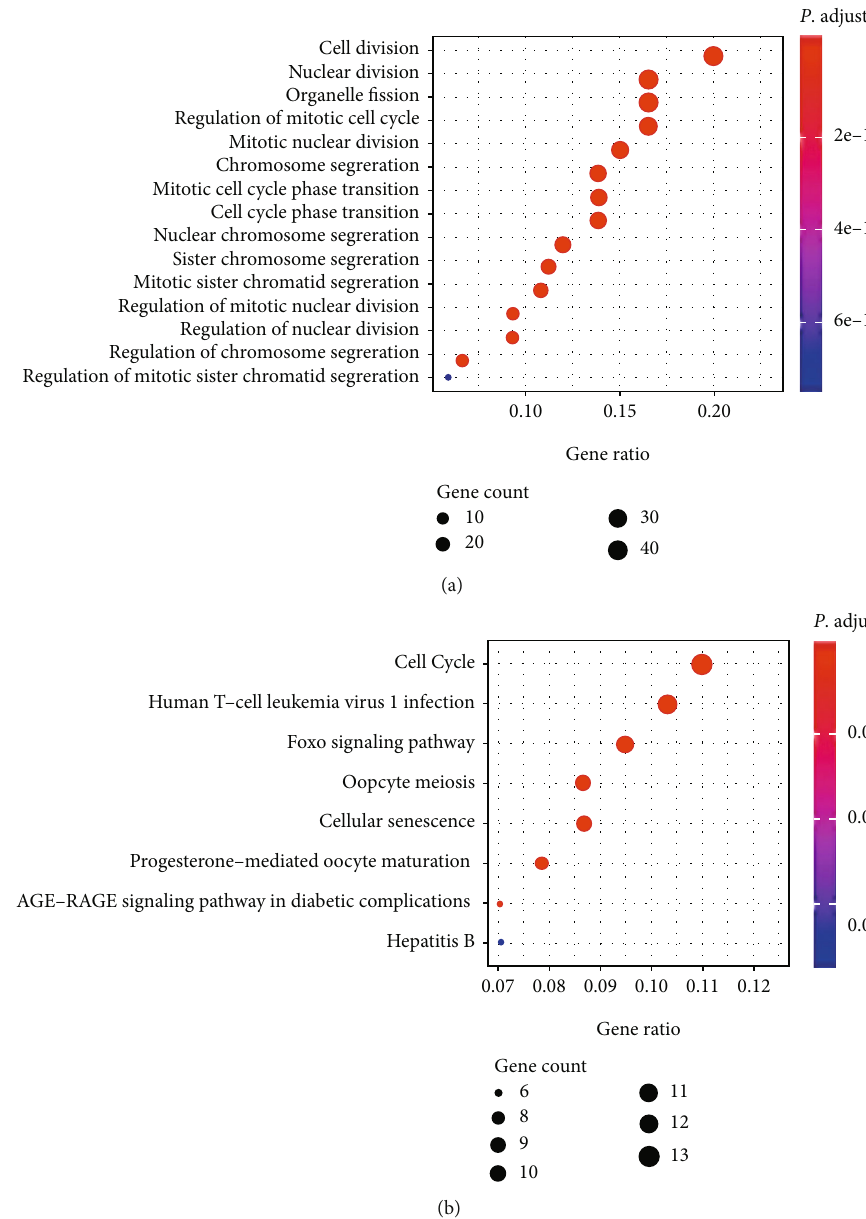
Figure 3: 10 hub genes and their interactions were obtained by MCC method. The top 10 hub genes were obtained by MCC method, which were NDC80, BUB1, CDCA8, FAM83A, BIRC5, CCNB1, KIF2C, CENPF, MAD2L1, and